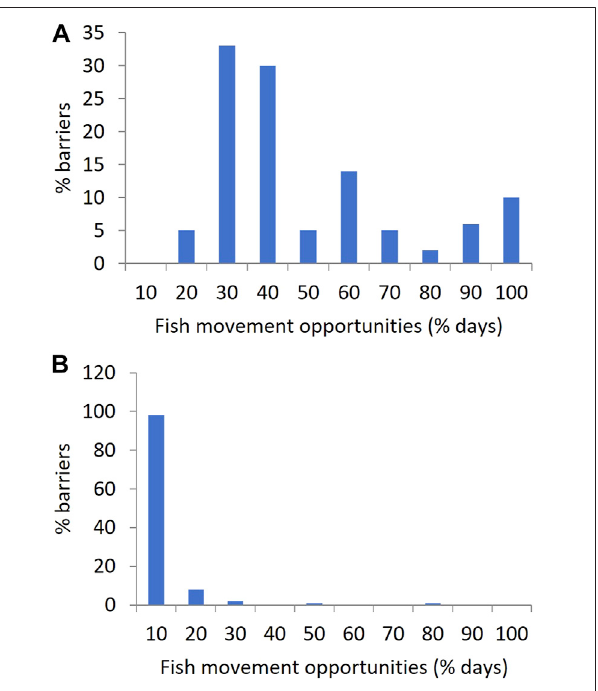
FIGURE 5 | Histograms showing the frequency with which fl ow at the locations of QMDB instream barriers provide fi sh movement opportunities, expressed as the percentage of days in their associated stream gauge records, in bins of 10%. (A) applying a fl ow threshold of 0.058 m 3 s − 1 (5 Ml day − 1 ) in the hypothetical absence of instream barriers, (B) with existing barrier drown out fl ow thresholds applied, representing the current